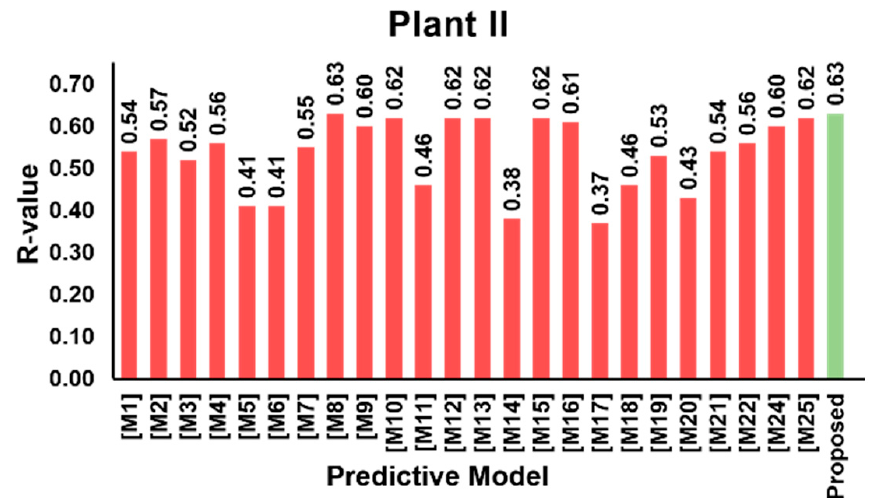
Figure 12. Comparison of R values for existing and proposed models for predicting dephosphorization in steel for Plant II.